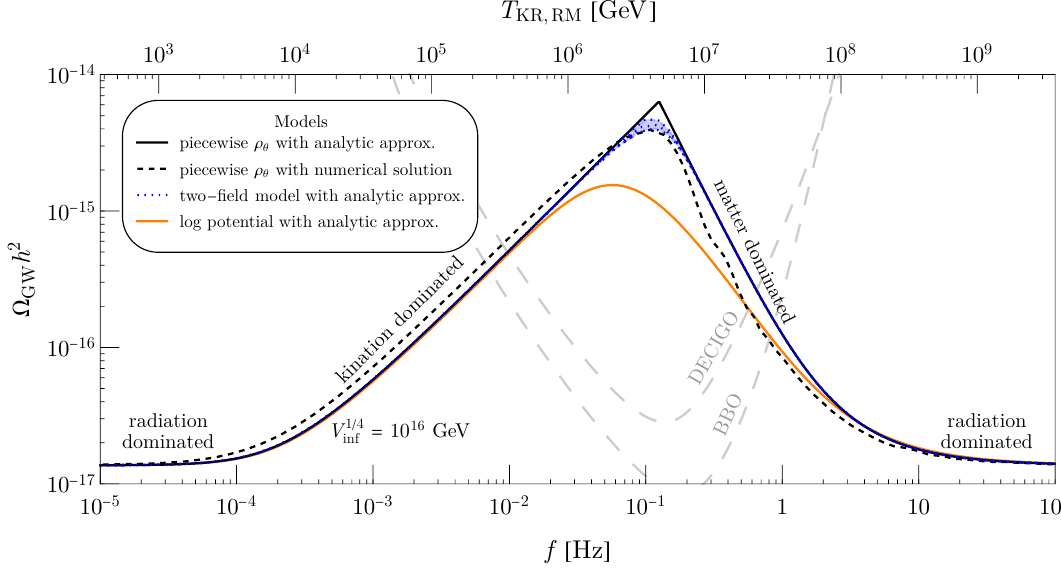
Figure 7 . An illustration of the model dependence in the primordial gravitational wave spectrum. Here we fix T KR = 10 4 GeV , T RM = 10 8 GeV (and accordingly T MK ’ 2 × 10 5 GeV ), and the inflationary energy scale V 1 / 4 = 10 16 GeV . The black lines are for the case where the rotation inf energy density ρ θ follows a piecewise scaling when T 7 T MK as shown in figure 1. The solid (dashed) black lines are obtained from an analytic (numerical) derivation of the evolution of the metric perturbations. The colored curves are for the two-field model (blue) and the logarithmic potential (orange) with evolution demonstrated in figure 1. For the two-field model, we show the blue dotted /m 2 curves for different ratios of the soft masses of the two fields ¯ P and P , m 2 ¯ = 1 , 2 , ∞ from top P P to